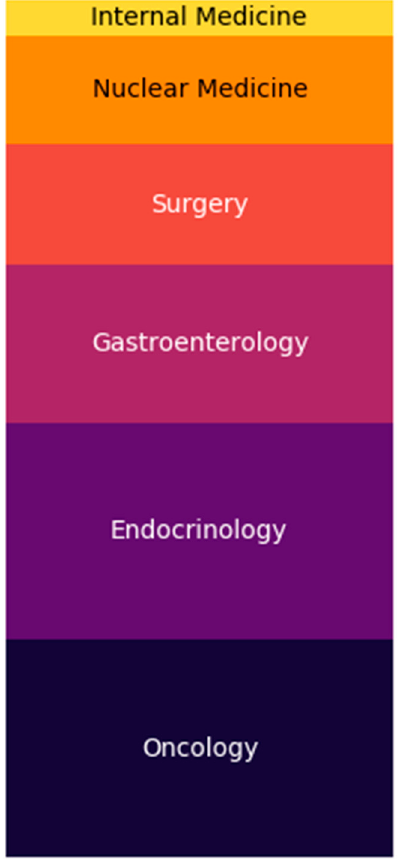
Figure 1. Survey responders’ discipline.